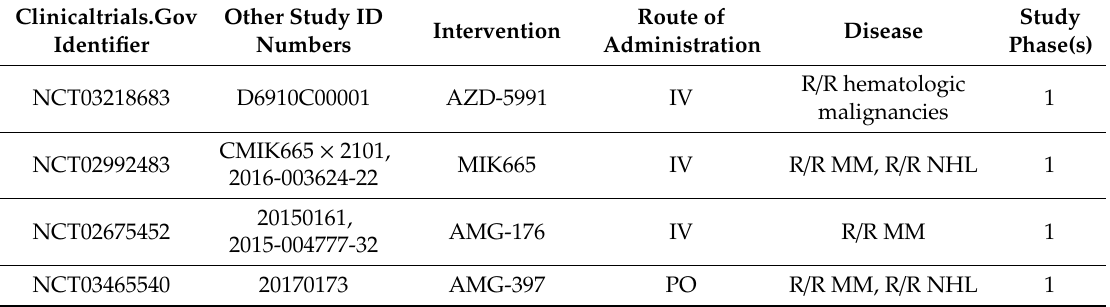
Table 4. Clinical trials of MCL1